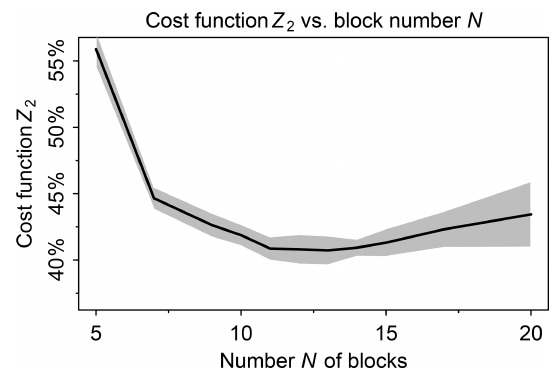
Figure 2. Minimum of cost function Z 2 (global fraction of chemi- cal species treated as fast) as a function of the number N of blocks used to group the species for mechanism reduction. Values were computed using the GEOS-Chem troposphere + stratosphere sim- ulation on the first days of February, April, August, and Novem- ber 2013, over 24h and sampled every 6h. Shaded area shows the standard deviation of the cost function minimum computed for each sample.